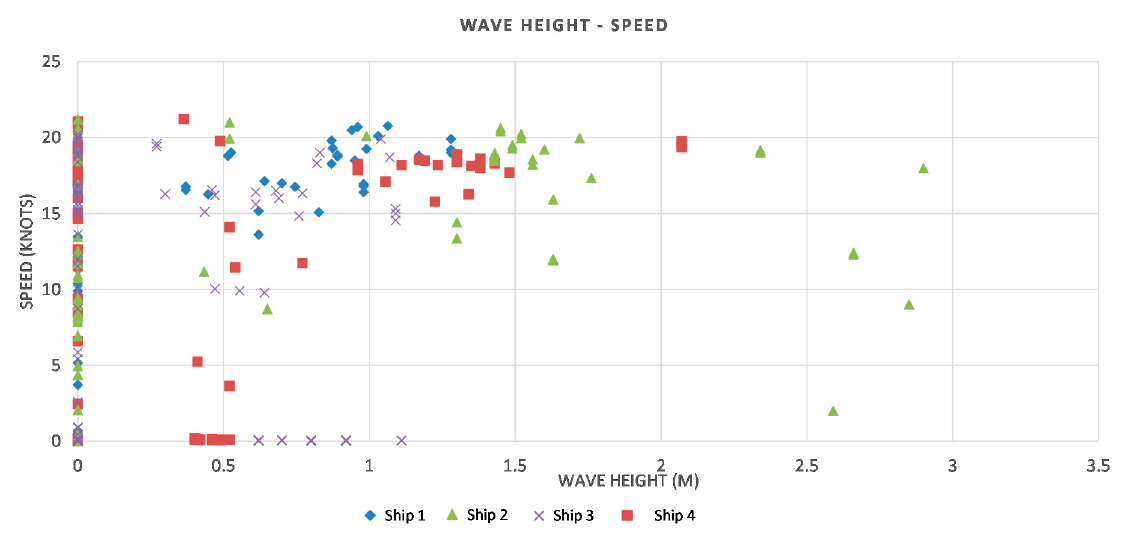
Figure 9. Analysis of the ship’s speed and the wave height.